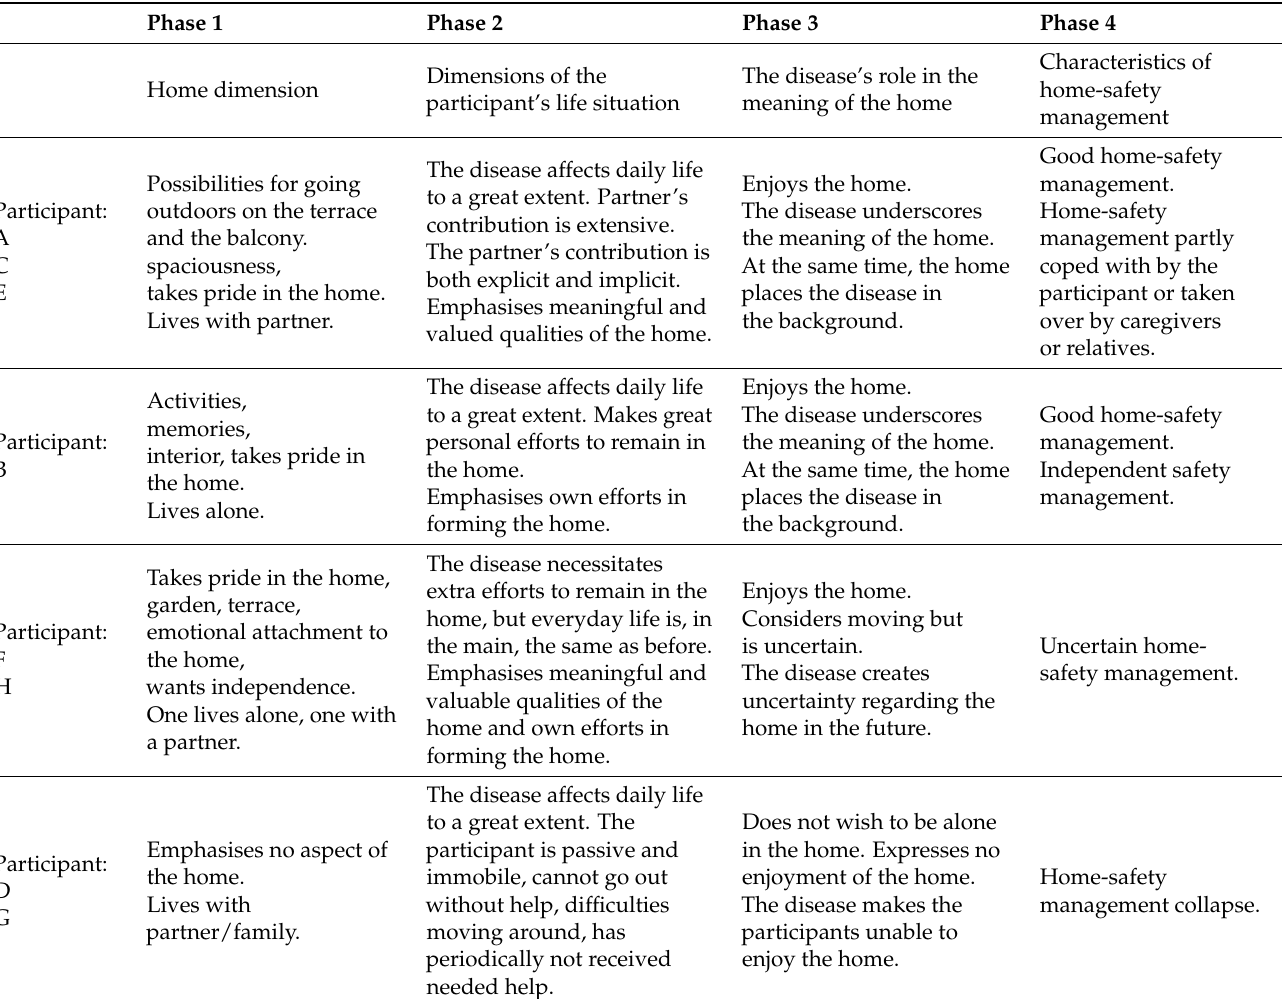
Table 3. Schematic overview of analysis phases and the characteristics of the participants and their connected home-safety